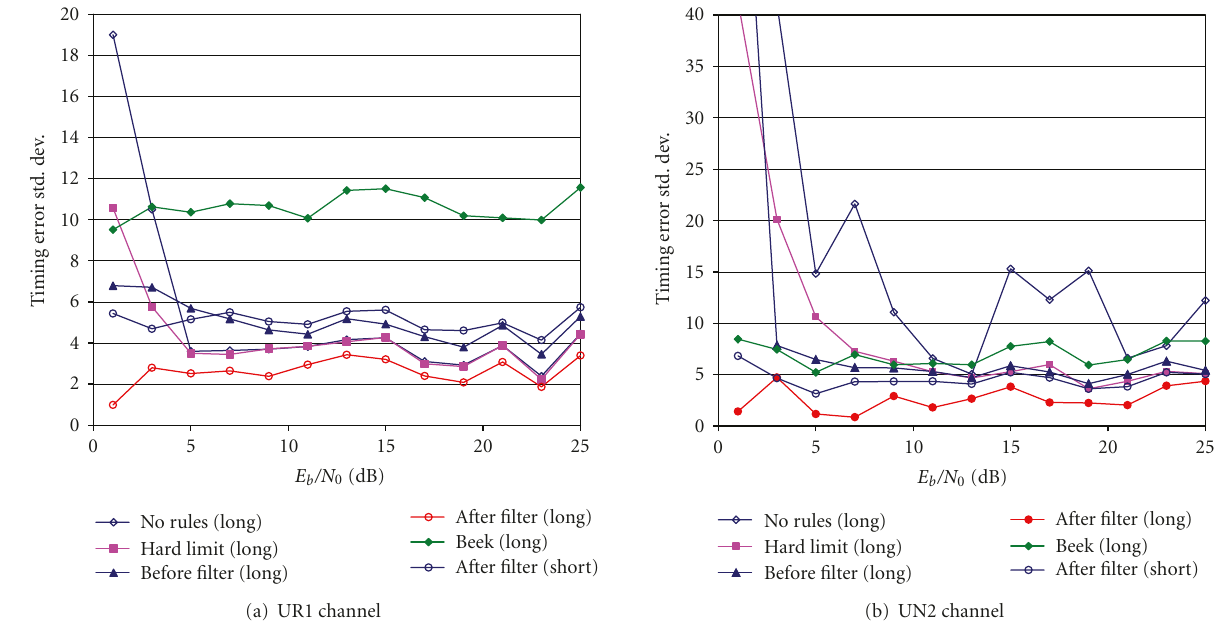
Figure 11: Performance of rule-based processing as a function of E b /N 0 .